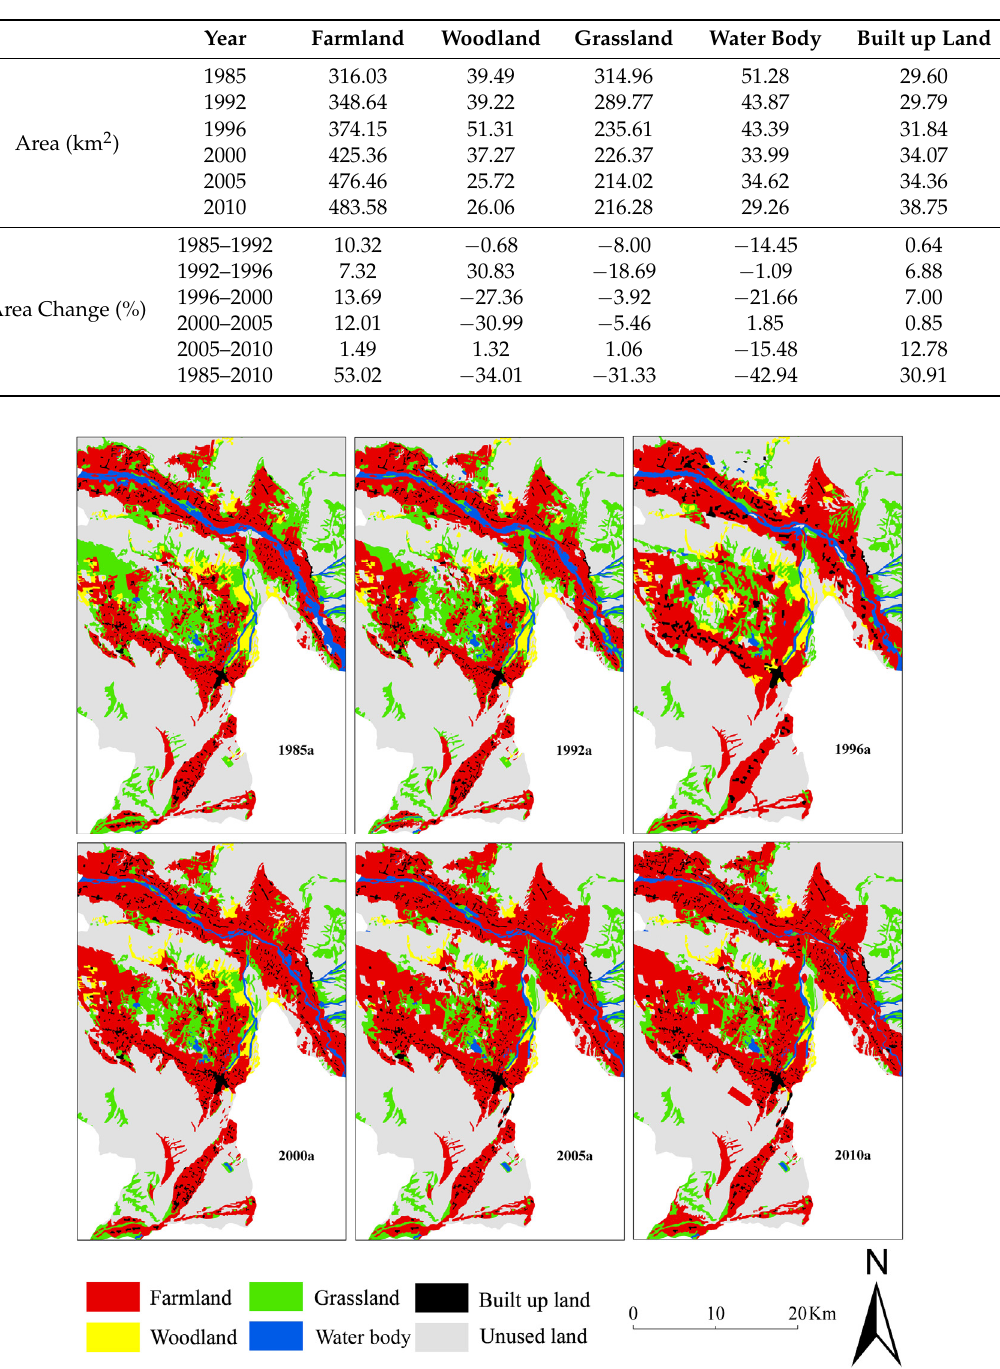
Table 6. Land use/cover change of Linze County.